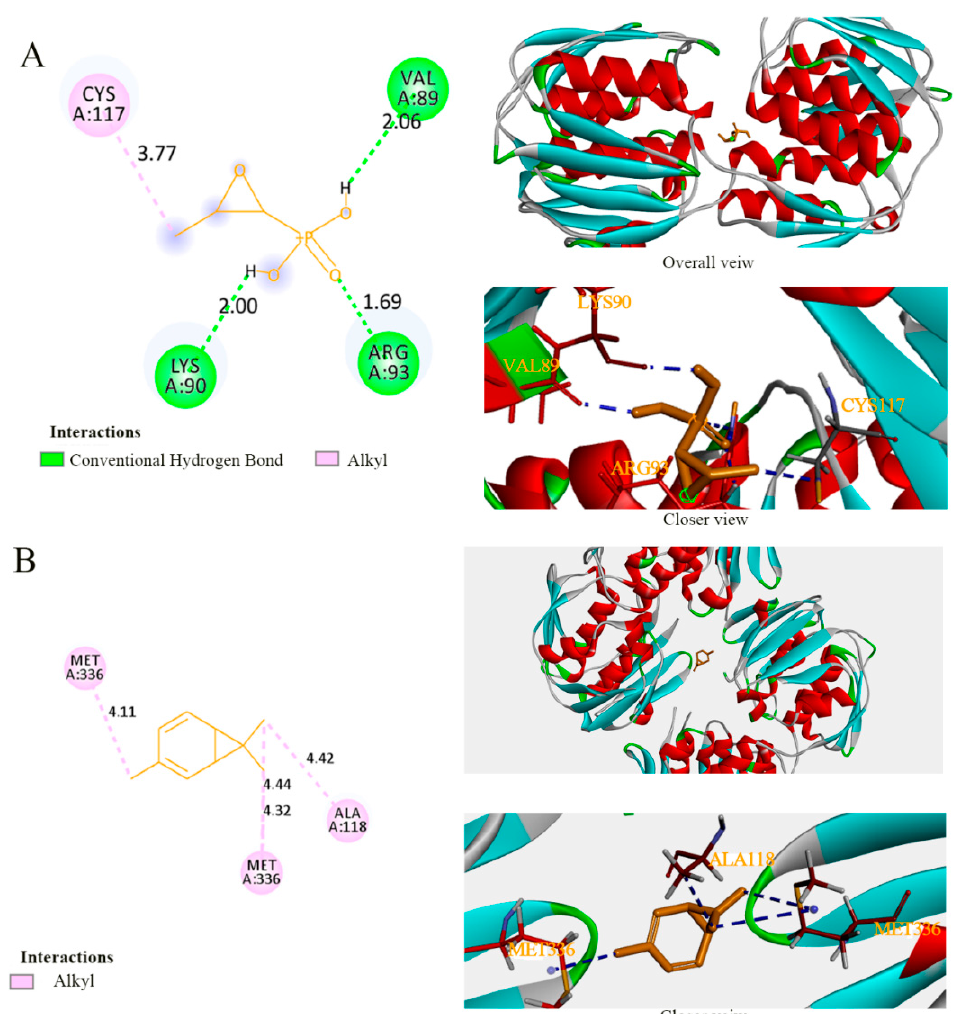
Figure 7. The binding details of MurA with fosfomycin ( A ) and 3-carene ( B ).